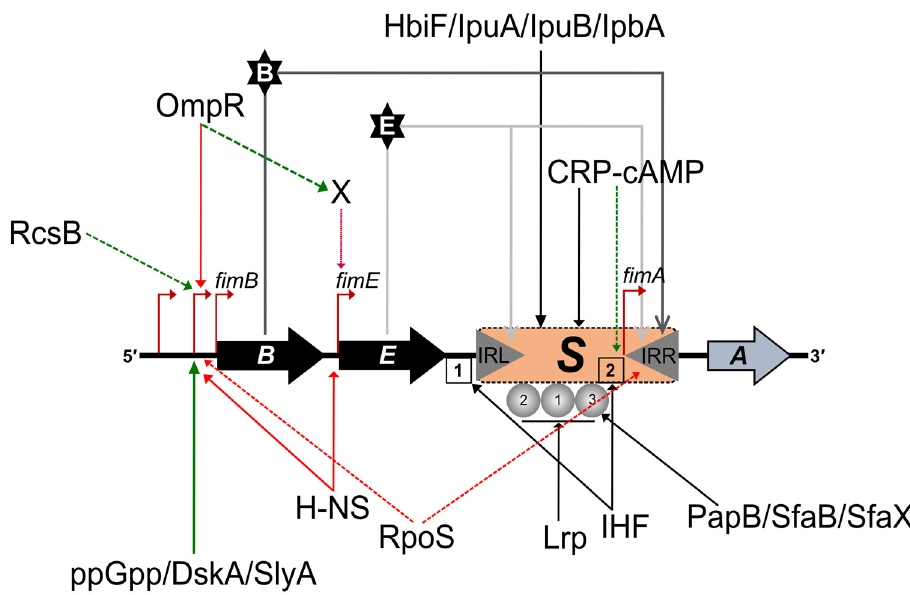
Figure 3. Auxiliary proteins known to influence the expression of type 1 fimbriae. A schematic of function/s of key auxiliary proteins in regulation of type 1 fimbriae is depicted. Invertible motifs, IRL and IRR within the fimS switch are indicated by grey triangles. IHFs (1, 2) and Lrp (1–3) binding sites are represented as open boxes and grey-coloured balls, respectively. Orientation and location of the fimB , fimE and fimA genes are also displayed. The identified promoters are shown as bent red arrows. Confirmed and presumed binding (of auxiliary proteins) associated with stimulatory effects is presented by solid and dashed green arrows, respectively; whereas confirmed and presumed binding (of auxiliary proteins) associated with repressing effects are shown by solid and dashed red arrows, respectively. Diagram is based on information from Schwan [53].